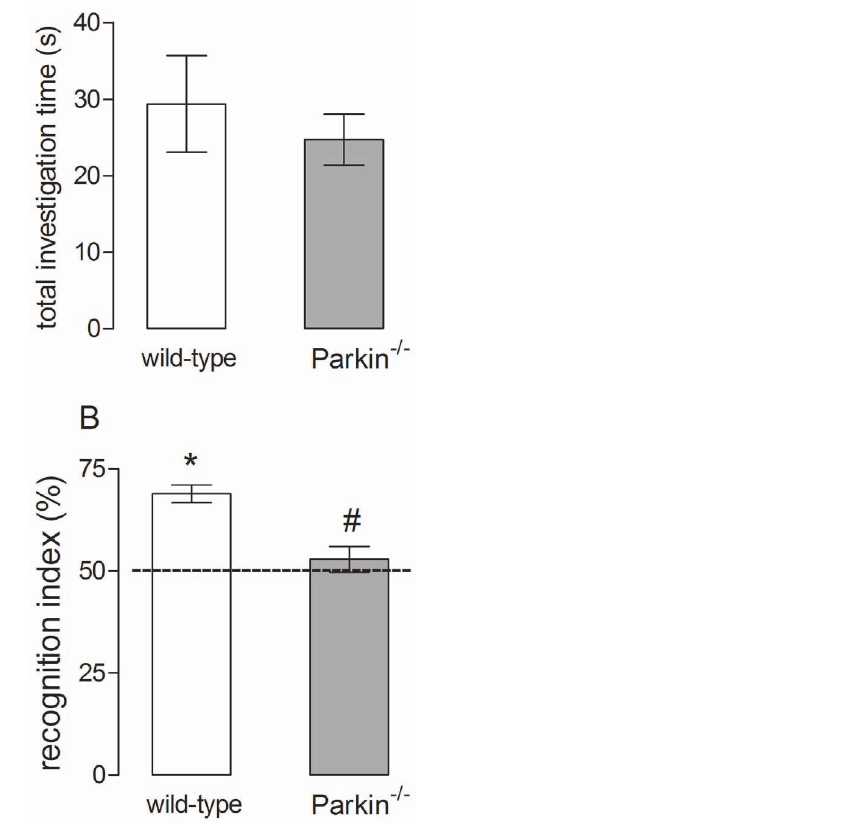
Figure 2. Effectsof parkin genetic deletionon the spatialmemory performance. (A) total investigation time by wild-type and parkin 2 / 2 mice during the training session. (B) Recognition index of wild-type and parkin 2 / 2 mice during the test session. *P , 0.05 compared to the hypothetical 50% (random investigation). # P , 0.05 compared to the wild-type control group. Data are mean ¡ s.e.m. of n 5 9–10 per